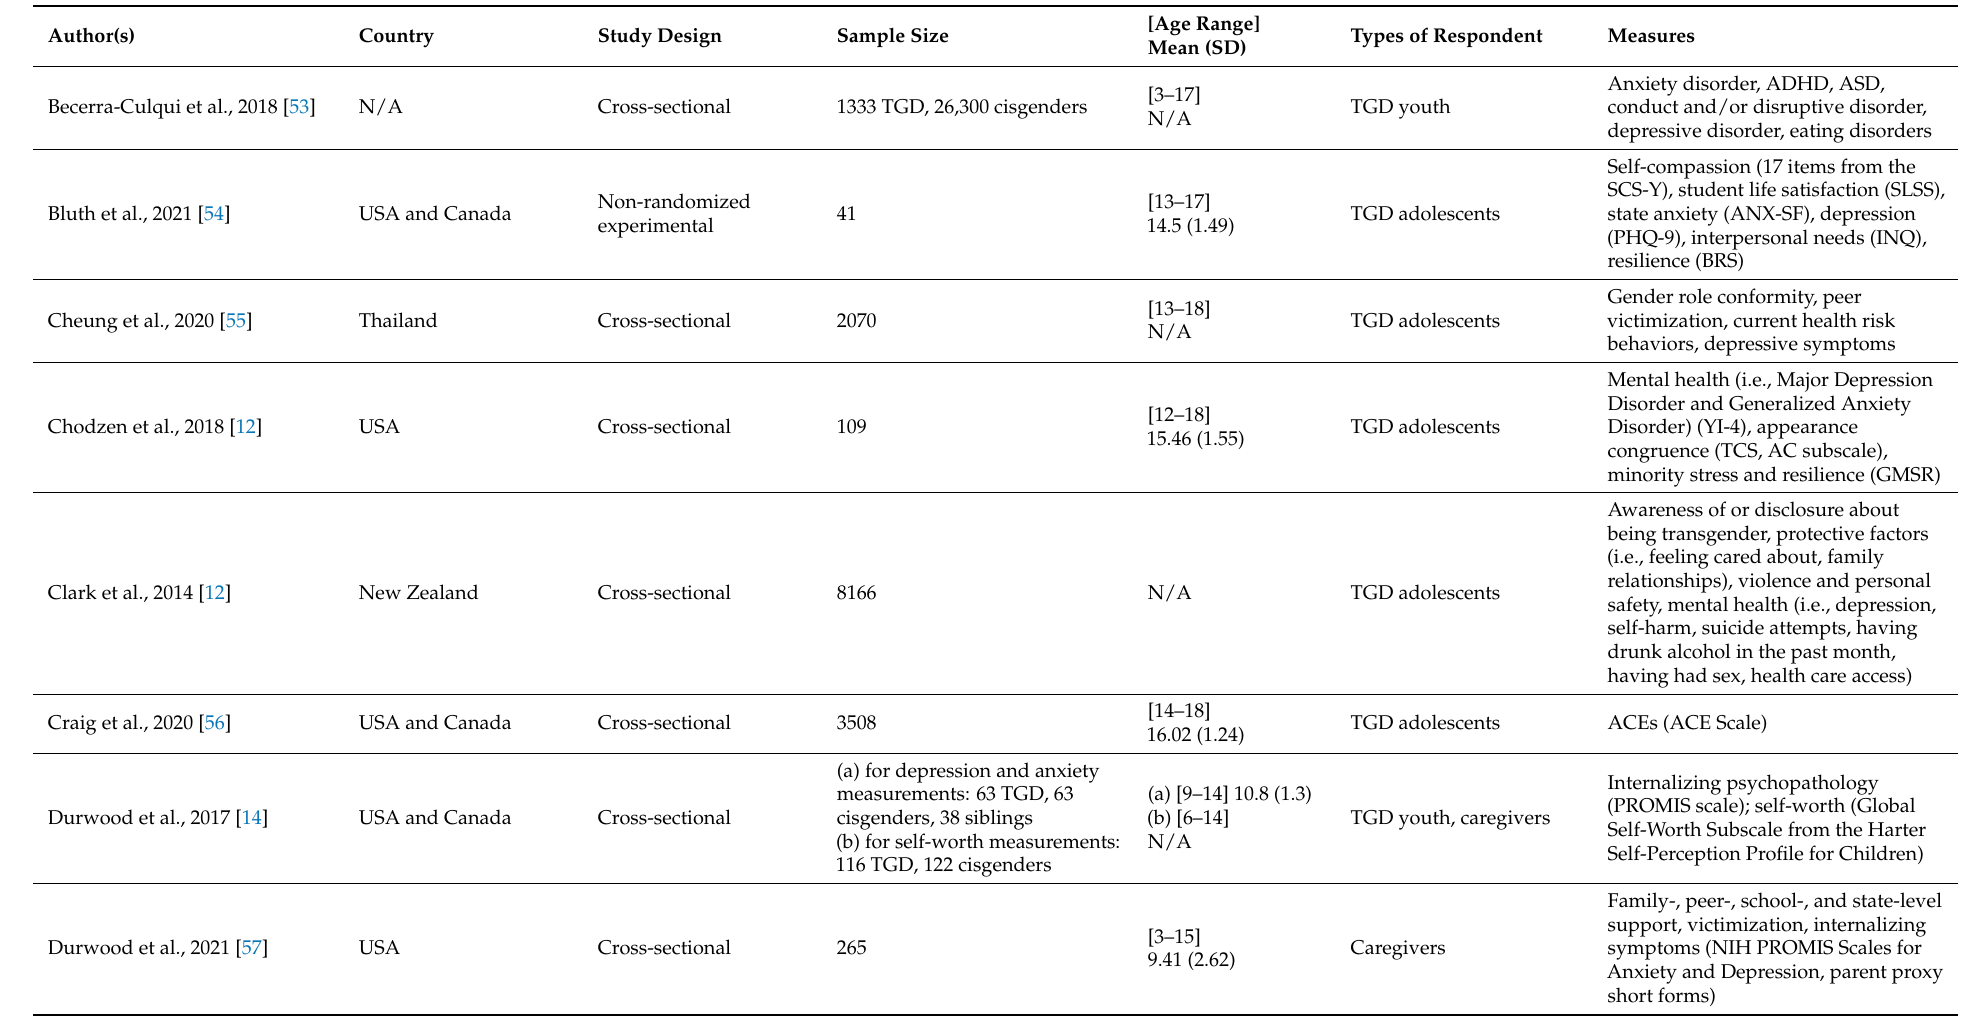
Table 1. Summary of included